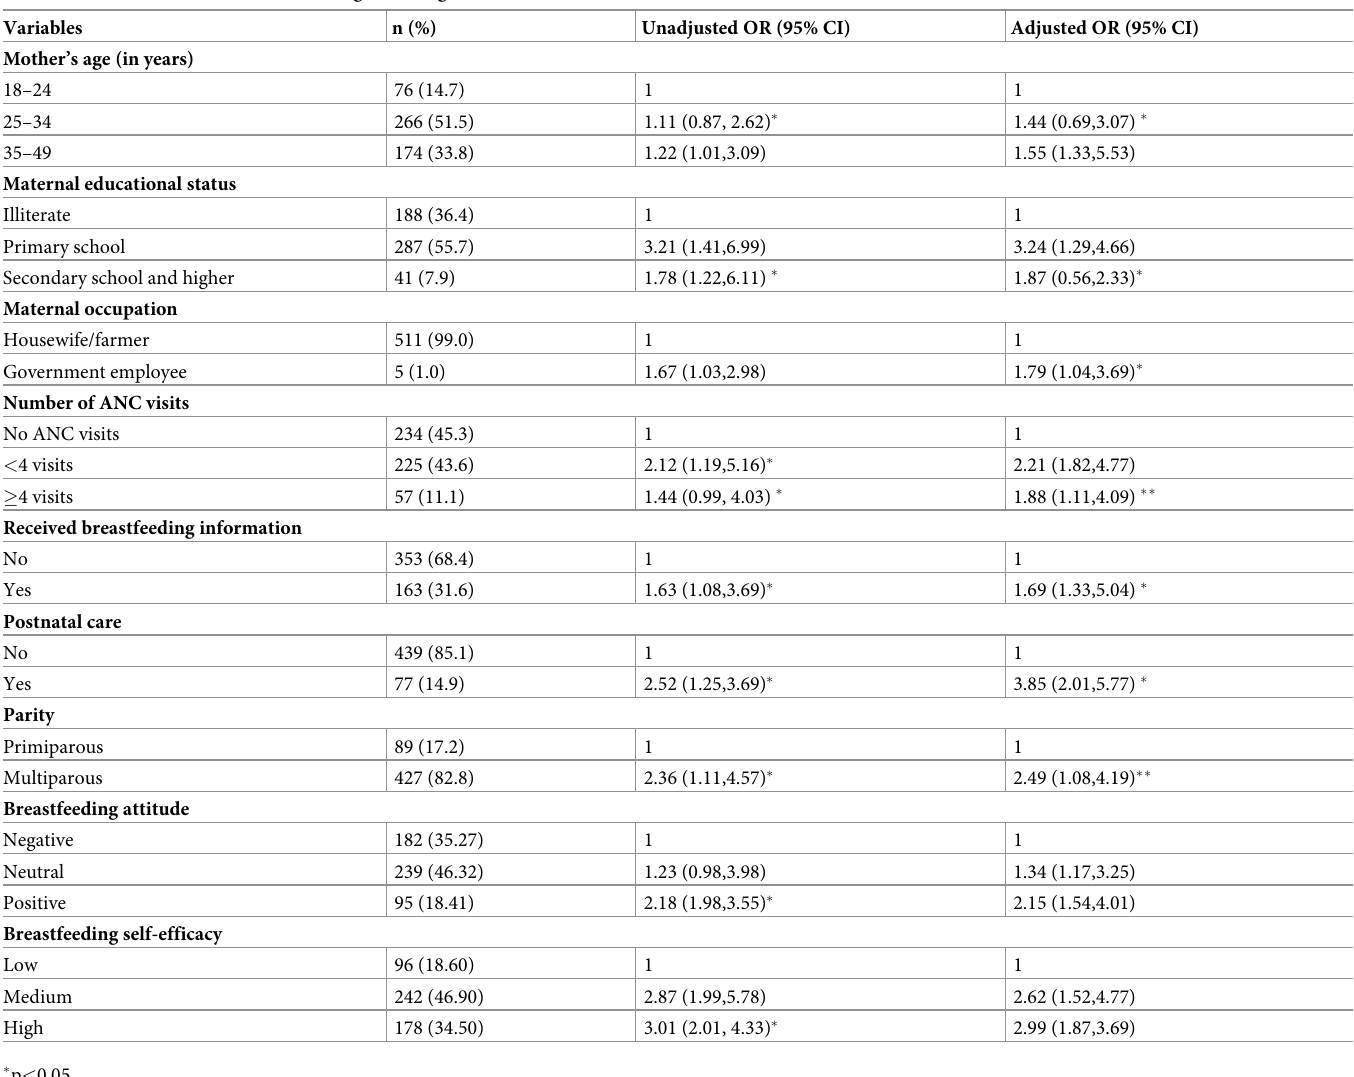
Table 3. Association between breastfeeding knowledge and their